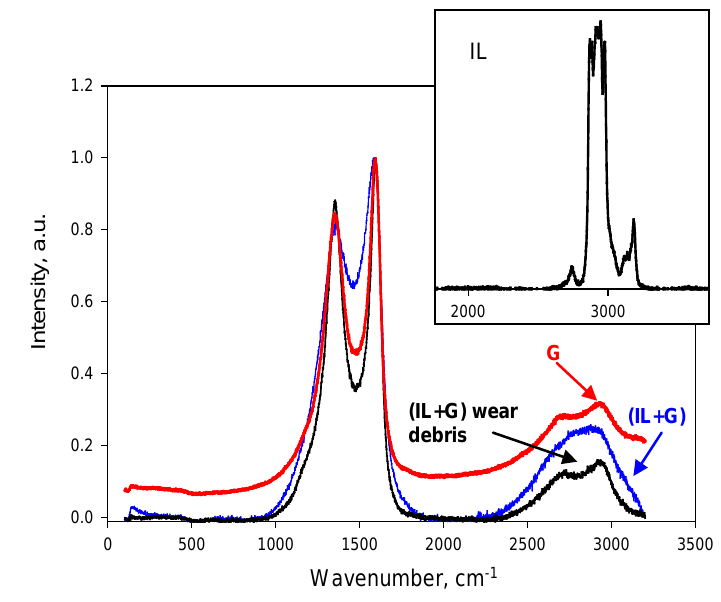
Figure 13. Raman spectra of graphene (G); (IL + G) dispersion and wear debris after lubrication with (IL + G). Inset: Raman spectrum of IL in the 2000–3000 cm − 1 region.